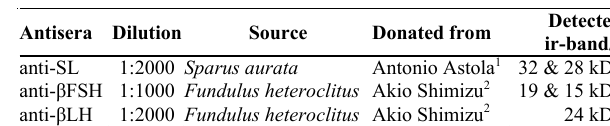
Table 1. Antisera used in the Western blot analysis and estimated molecular mass of Cichlasoma dimerus pituitary